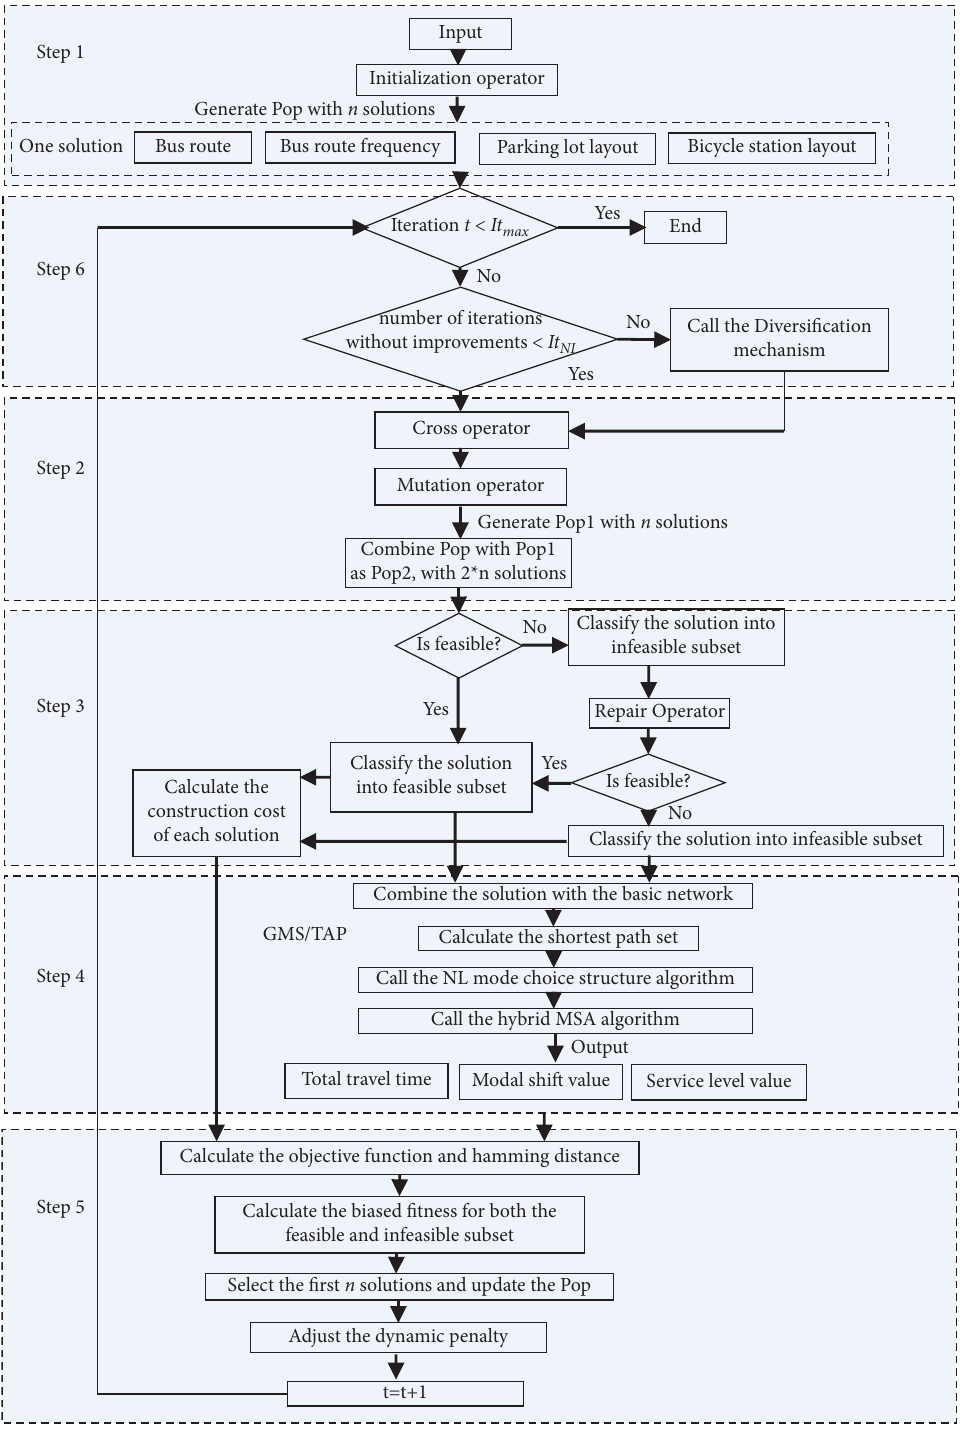
Figure 20: Extracts of the